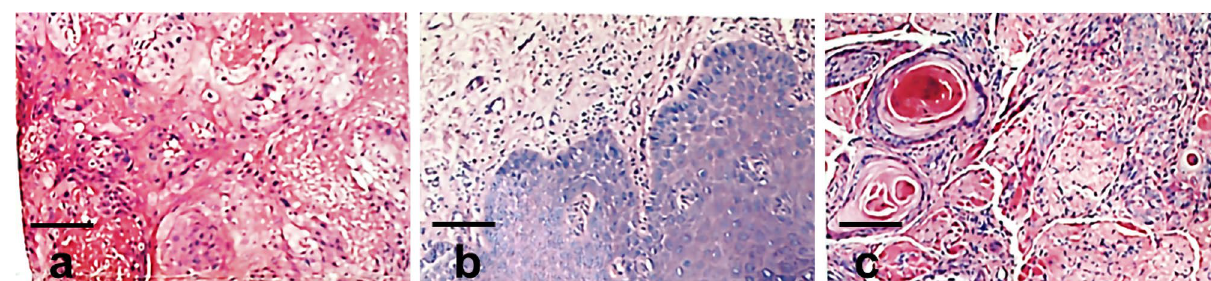
Figure 6. HE stains of OL patients with severe dysplasia at t0 ( a ), t1 ( b ) and t2 ( c HE stains in new areas). The pathological characteristics of the oral lesions at t0, t1, and t2 in the YSGG-PDT treatment of OL patients with severe dysplasia were analyzed by HE staining. Scale bar 500 μm. Magnification: HE ×